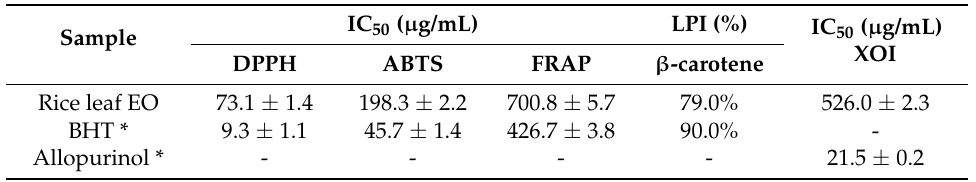
Table 1. Antioxidant activity measured by DPPH, ABTS, FRAP, β -carotene bleaching assays, and XOI activity of rice leaf EO in terms of IC 50